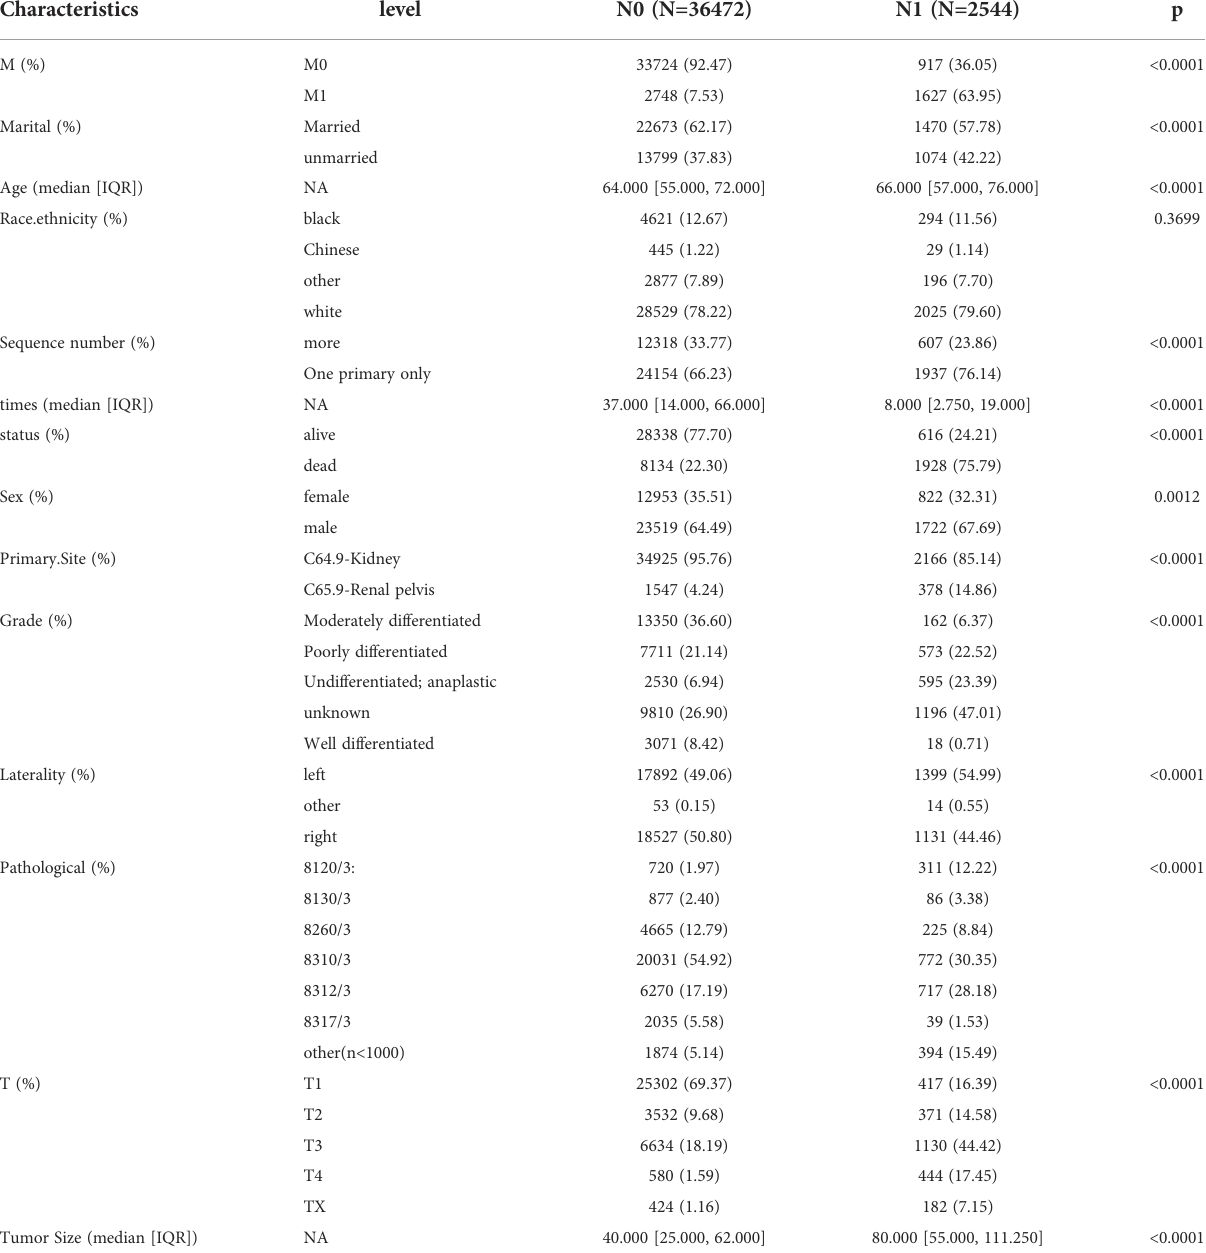
TABLE 1 Baseline of renal cell carcinoma patients with and without lymphatic metastasis.